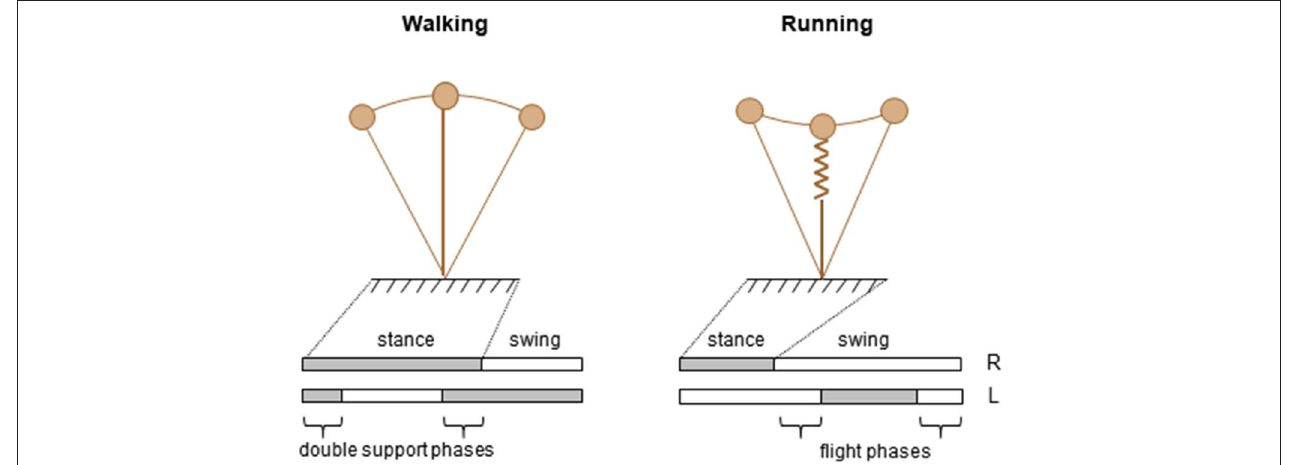
FIGURE 1 | Schematic representation of two modes of human locomotion during stance